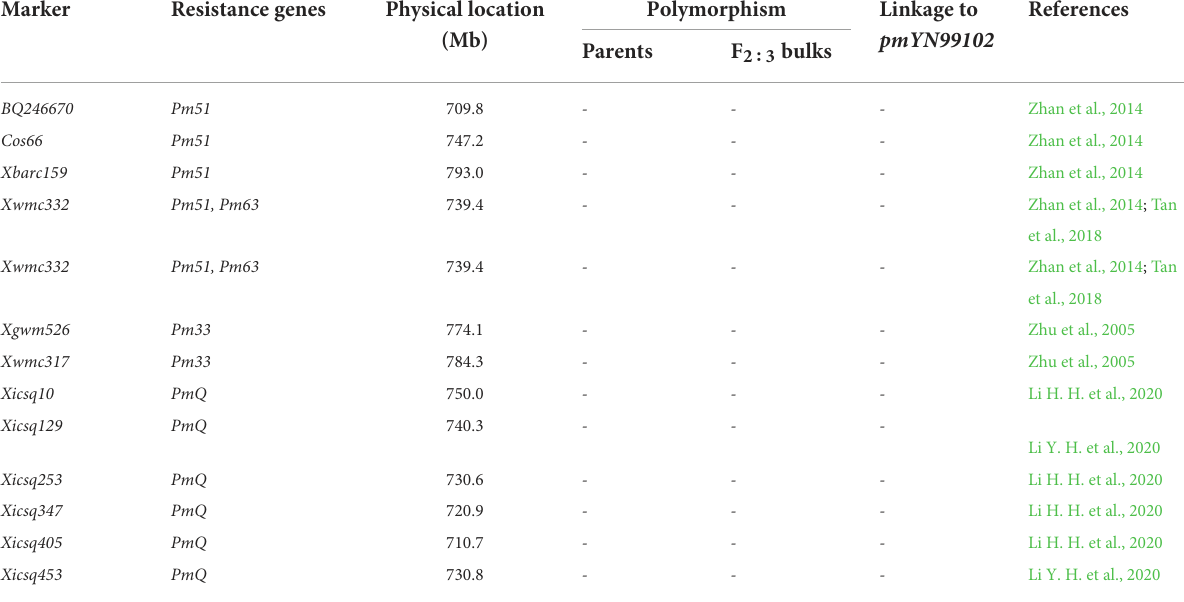
was likely located in this 33.7 Mb interval on chromosome